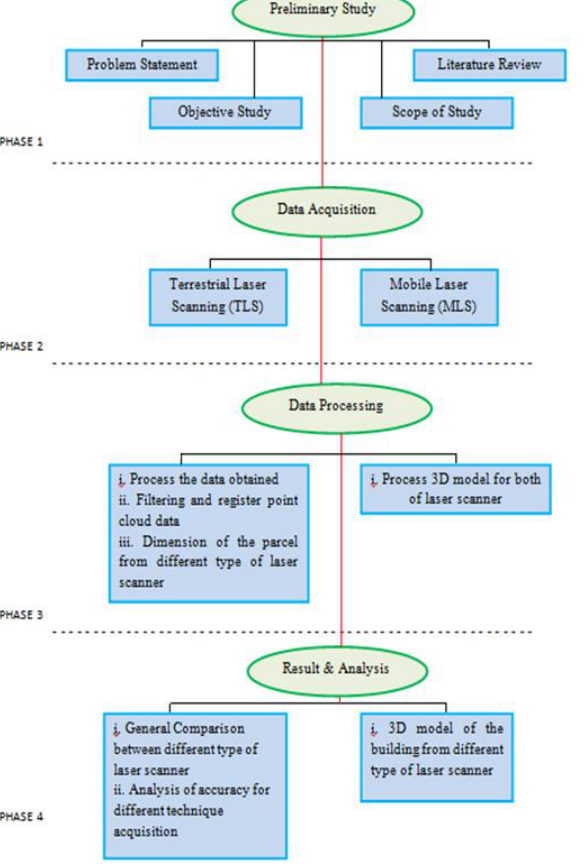
Figure 3: Methodology flowchart.